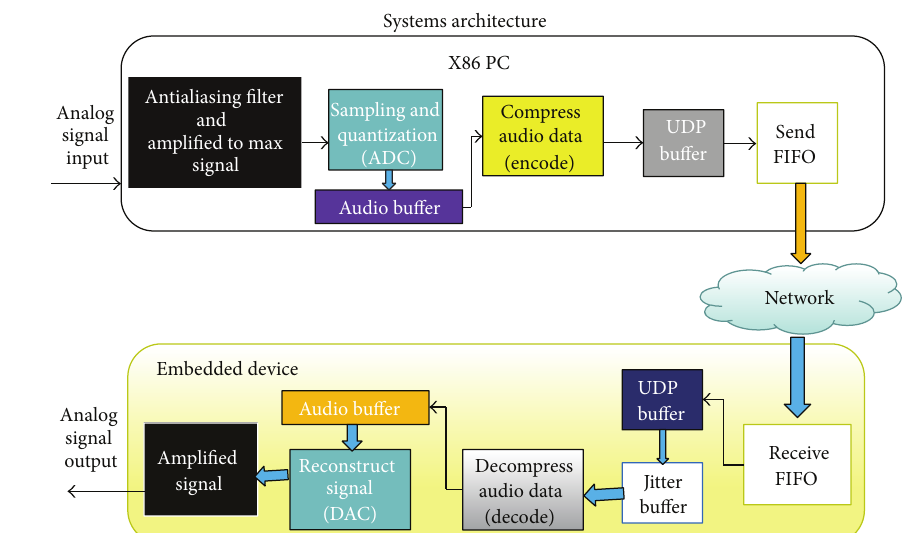
Figure 6: The physical architecture of signal